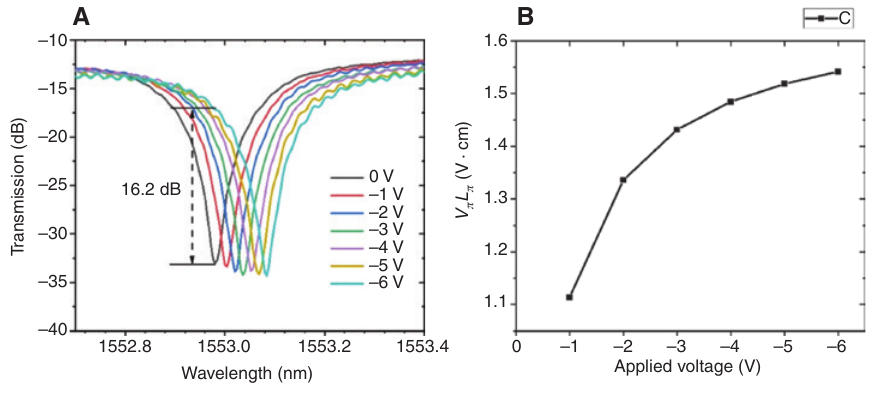
Figure 6: Electro-optic response of the microring modulator. (A) Wavelength shift with the bias voltage applied on the PN junction. (B) Calculated modulation efficiency V